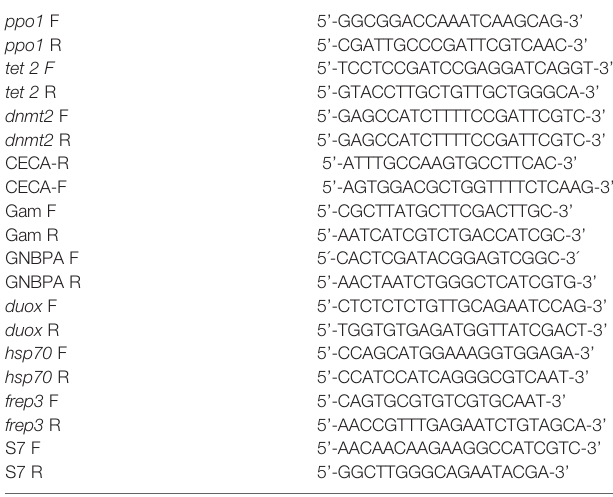
TABLE 1 | Oligonucleotides used to amplify the mRNA transcripts of A. albimanus